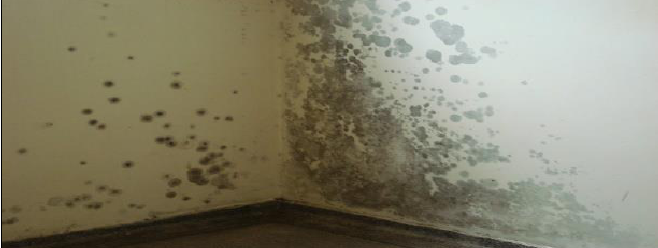
Figure 4: Wall mold caused by moisture.